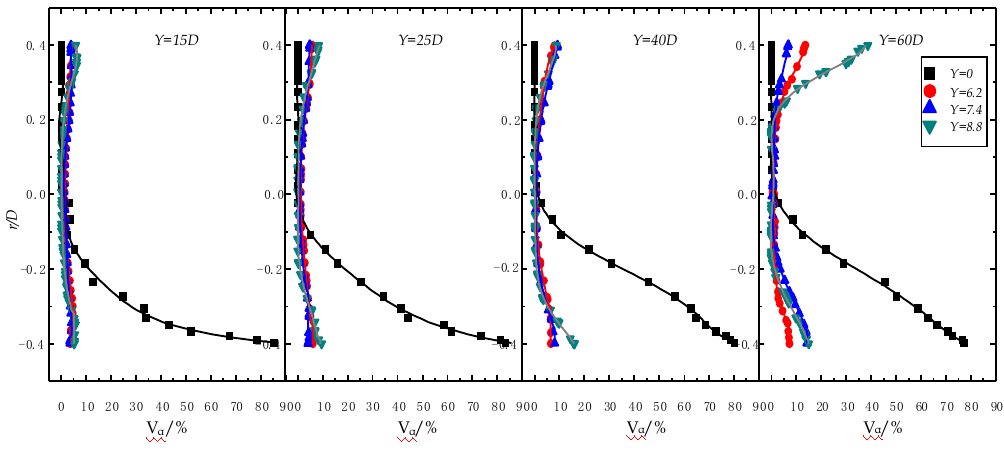
Figure 17. Graph of particle volume fraction at each section under different twist conditions at Re = 20,000.